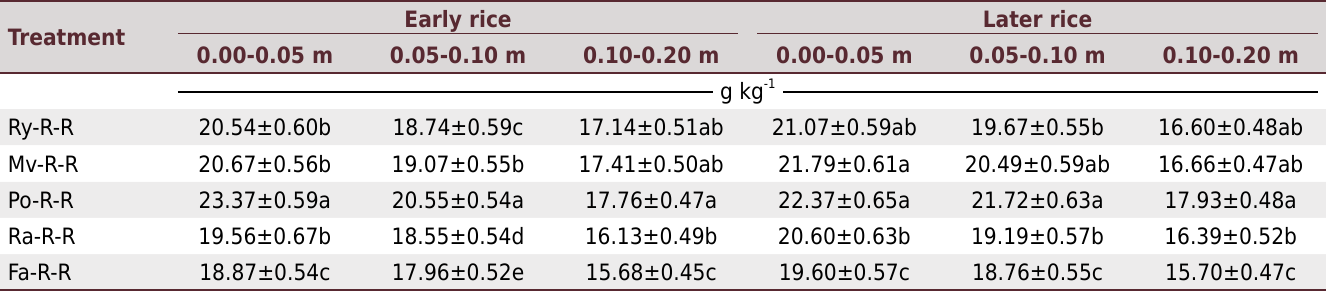
Table 1. Total organic carbon content in the 0.00-0.05, 0.05-0.10, and 0.10-0.20 m layers at the early rice and later rice maturity stages